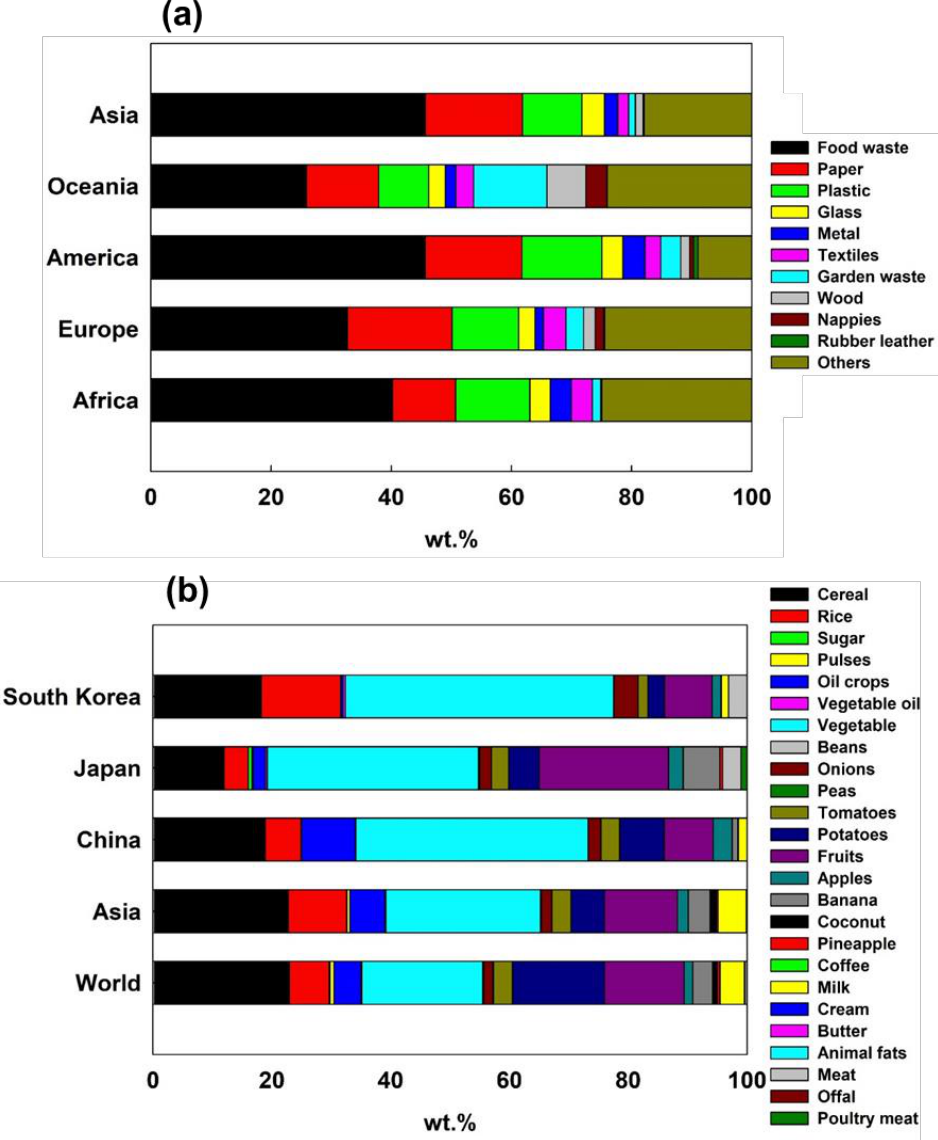
Figure 1. ( a ) Composition of municipal solid waste in wt.% (modified from [4]). ( b ) Typical food waste in the Asia-Pacific region and worldwide in wt.% (modified from [7]).